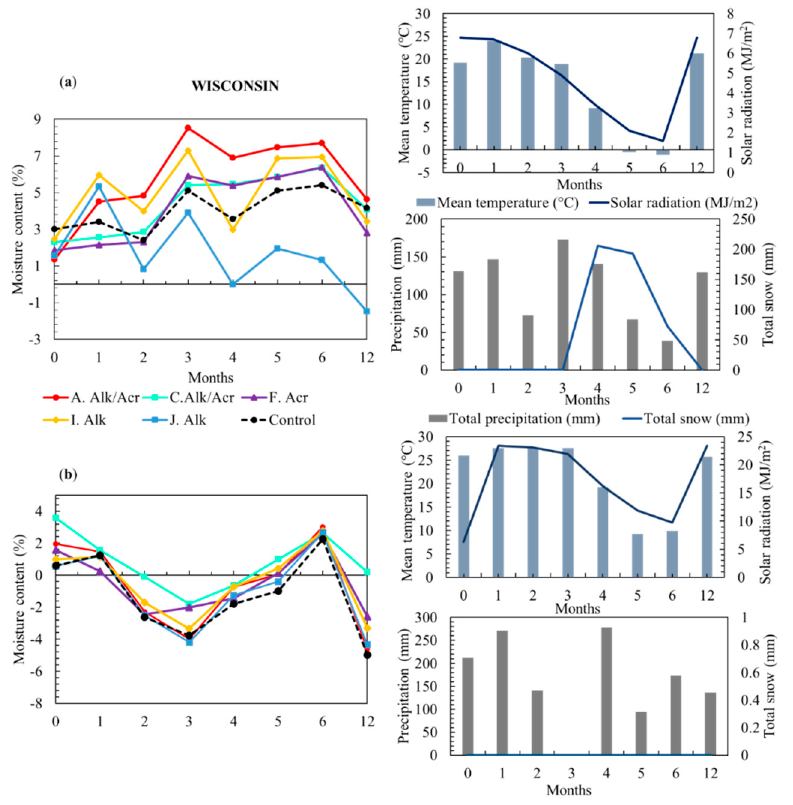
Figure 6. Moisture content of uncoated and coated samples exposed to 12 months of natural weathering in ( a ) Wisconsin and ( b ) Mississippi. weathering in ( a ) Wisconsin and ( b )